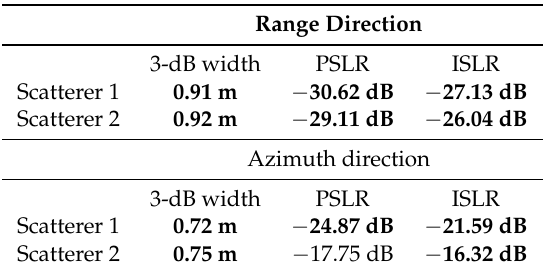
Figure 17. ( a ) Azimuth response comparison of Scatterer 1 in Area 1 and ( b ) azimuth response comparison of Scatterer 2 in Area 2. Table 3. Focusing quality of the proposed